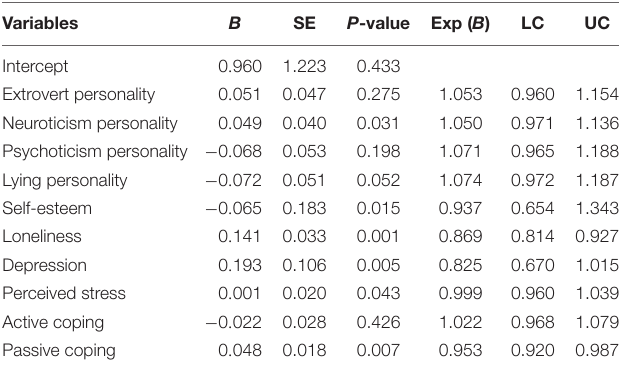
TABLE 3 | Risk factors for development and maintenance of smartphone